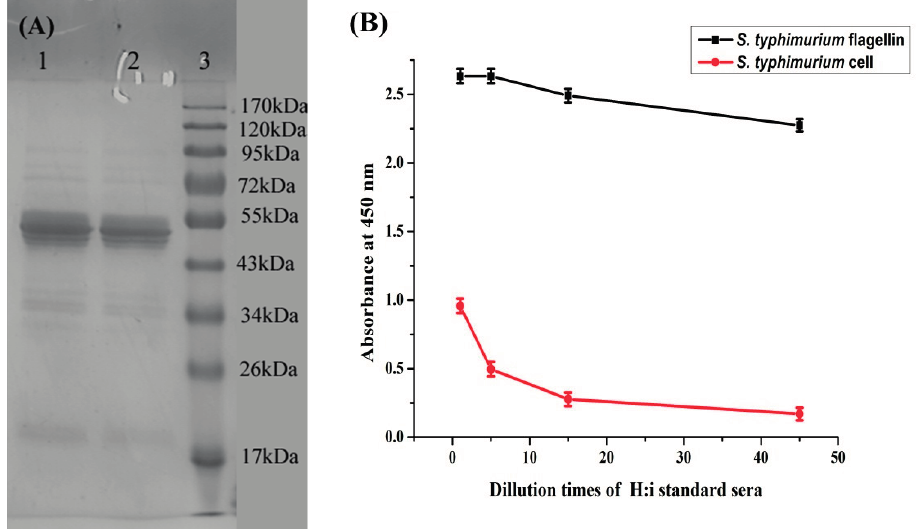
Figure 1. ( A ) SDS-PAGE of prepared flagellin from S. typhimurium . Line 1 and 2: Flagellin sample. Line 3: Standard weight protein Maker; ( B ) Characterization of S. typhimurium flagellin preparation by indirect ELISA. Red line is control with S. typhimurium cell as coating antigen.